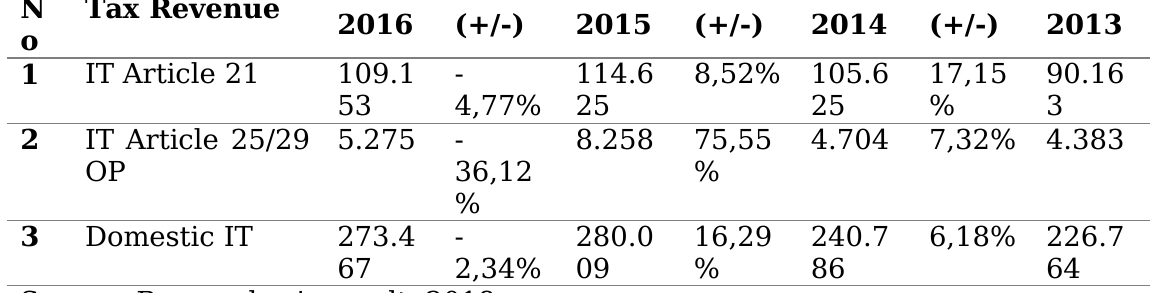
Table 2. Ratio of Realization in Domestic Tax Revenue Non-oil and gas and